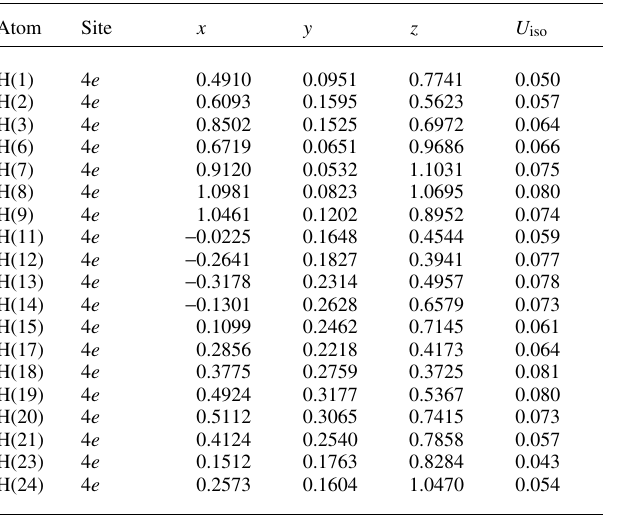
Table 2. Atomic coordinates and displacement parameters (in Å 2 )